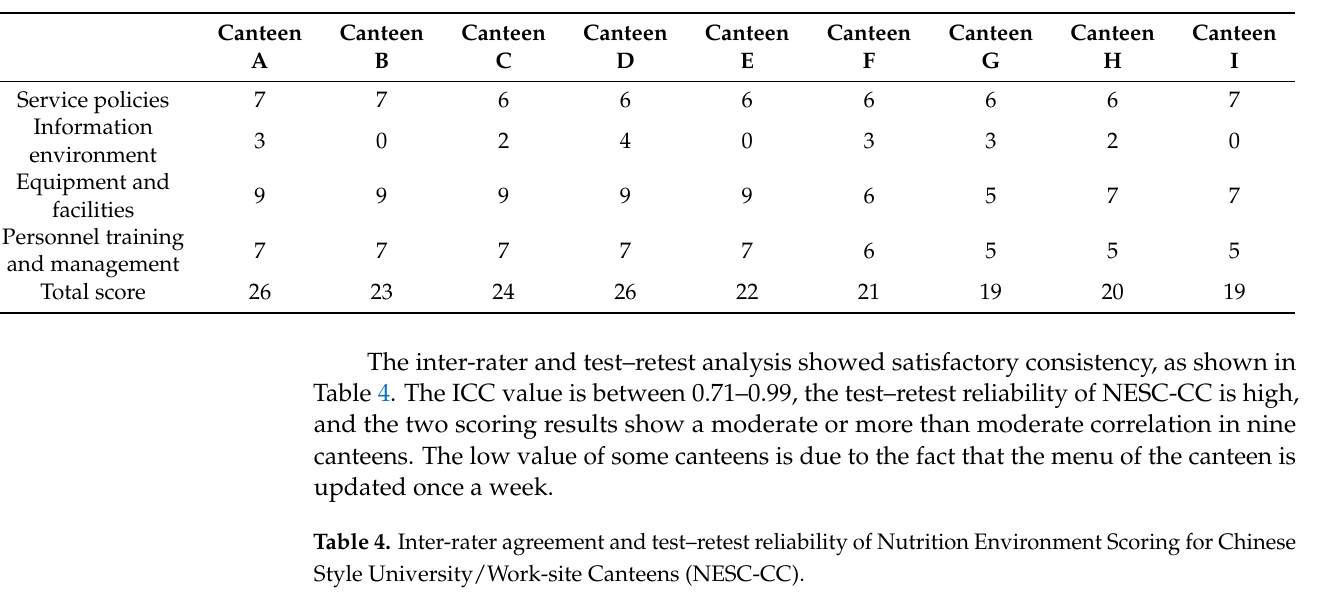
Table 3. Score of other factors that support healthy choices in nine canteens.